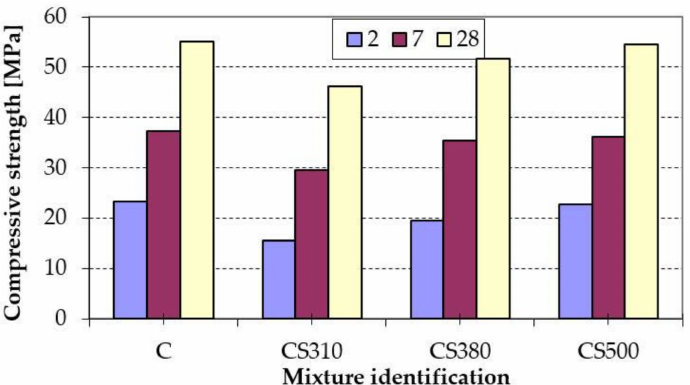
Figure 2. Compressive strength of Portland cements.